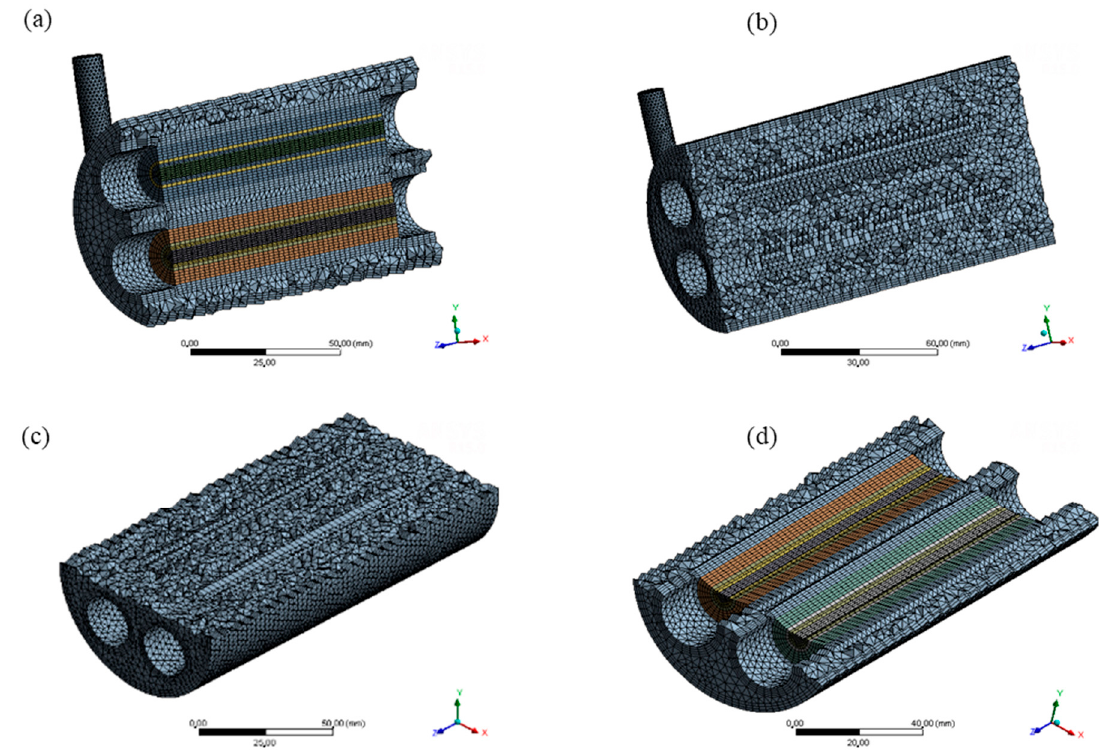
Figure 2. Mesh 2 of the separation module, highlighting the hull, membranes and permeate regions